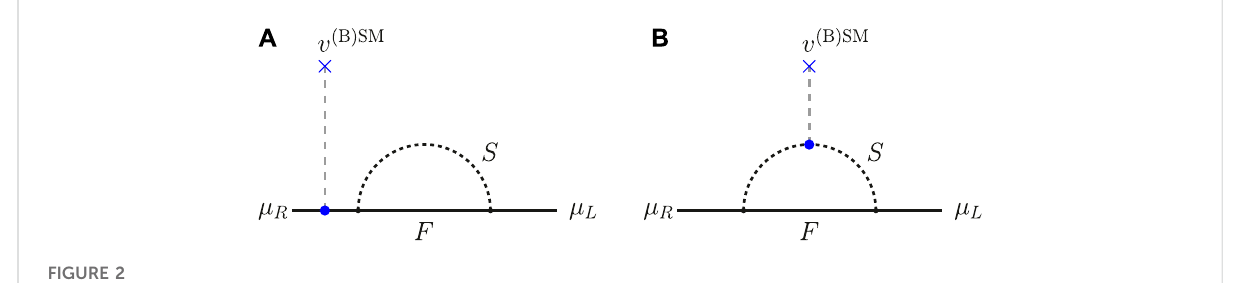
FIGURE 2 ConcreteinstancesofthegenericdiagramofFigure1.Inthe (A) diagram,themuonchiralityis fl ippedattheexternalmuonline via acouplingto an EWSB VEV. In the (B) diagram, the muon chirality is fl ipped via the loop, and the EWSB VEV couples to the scalar particle in the